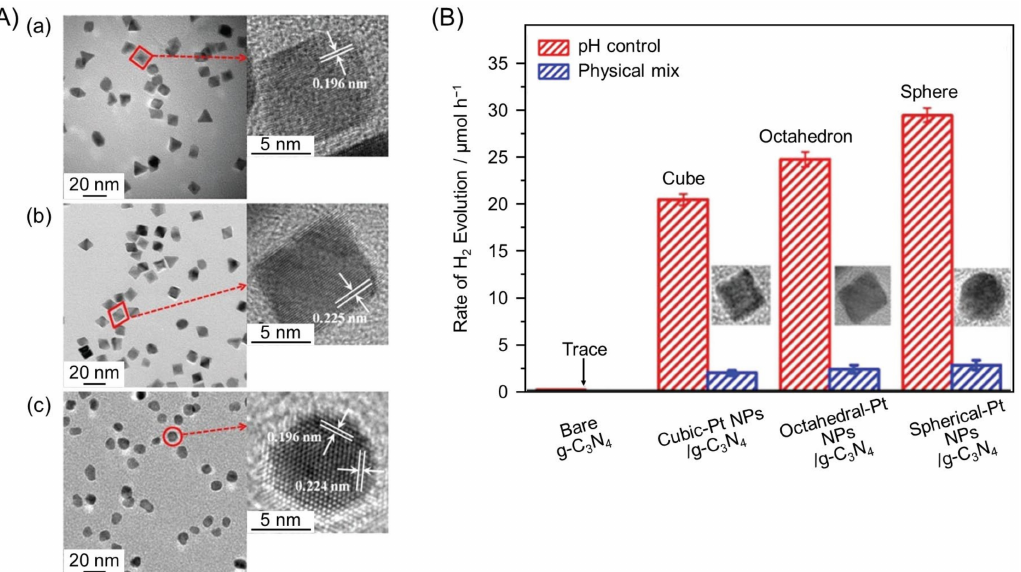
Figure 23. ( A ) TEM images and size distributions of dominant ( a ) cubic-, ( b ) octahedral-, and ( c ) spherical-Pt NPs. Insets show high-resolution (HR)-TEM images of a single Pt nanocrystal for each shape. ( B ) Photocatalytic H 2 evolution activities of bare g-C 3 N 4 , as-prepared Pt NPs/g-C 3 N 4 photocatalysts, and physically mixed samples under Vis-light irradiation ( λ > 400 nm) within 1 h. Reproduced with permission from reference [221]. Copyright 2016 The Royal Society of